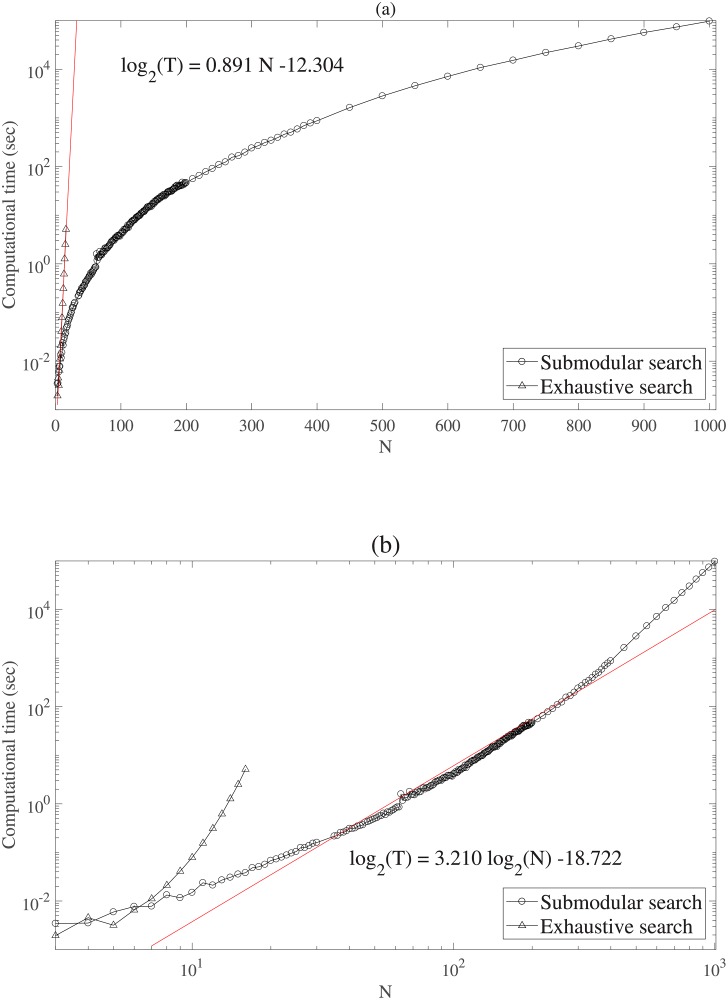
(a) The semi-logarithm plot and (b) log-log plot of the computation time for the two searches.